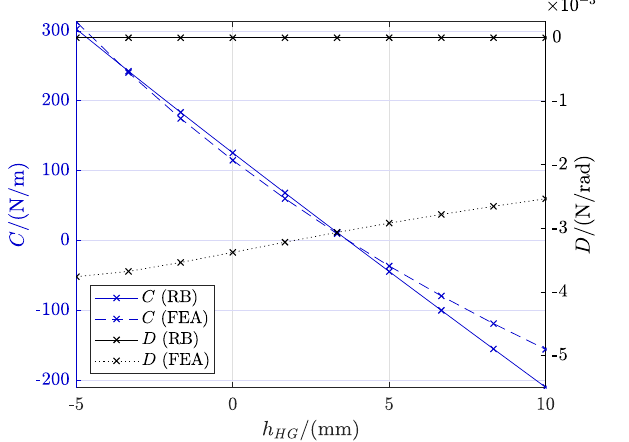
Figure 7. Variation of h HG in combination with a probe mass of m S 6 = 1kg compensates for the stiffness from restoring forces of the flexure hinges. The comparison with the rigid body model shows that the linearization is an approximation of the true behavior. This is especially relevant if h HF approaches zero; see Fig. 5.